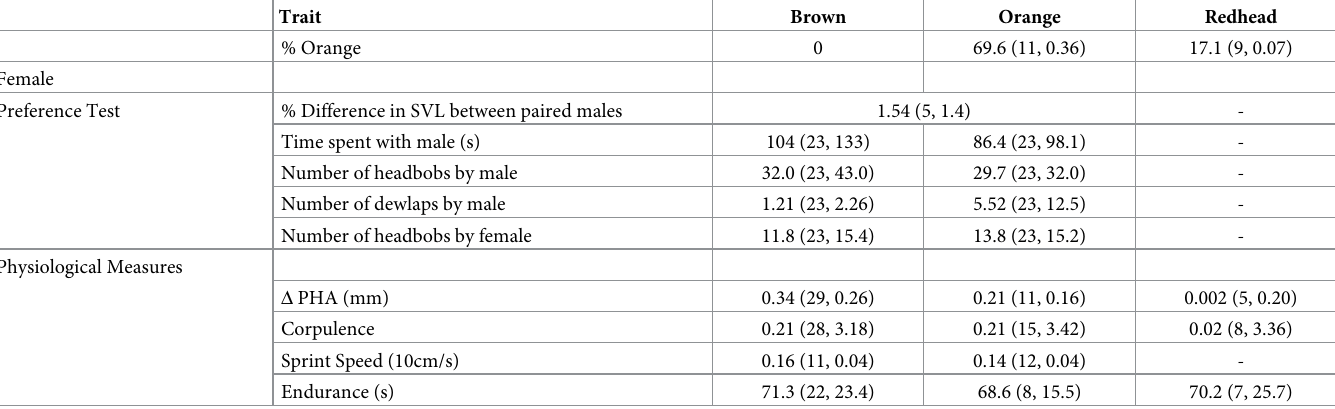
Table 3. The means and standard deviations of traits measured in this study. Presented as: mean (N, SD).